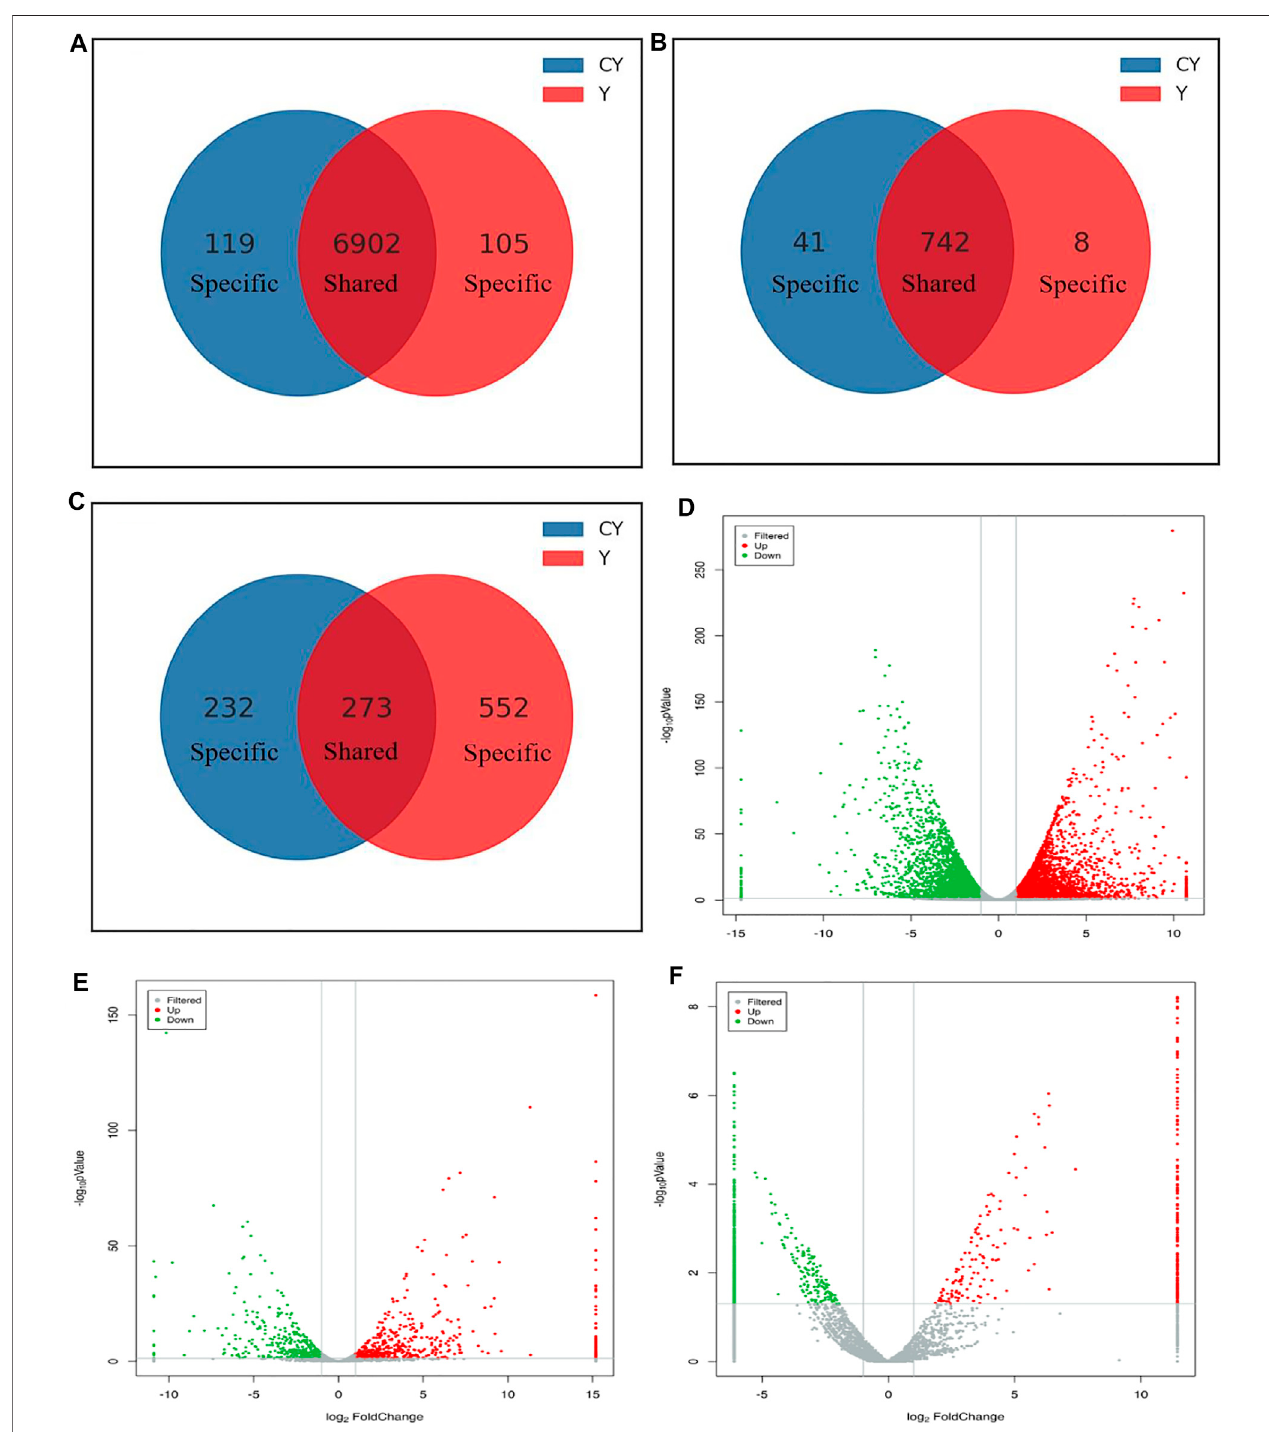
FIGURE2| ComparativeanalysisofthedifferentiallyexpressedmRNAsandncRNAsbetweencattle-yaksandyaks.Thespeci fi candsharedmRNAs (A) ,lncRNAs (B) , and circRNAs (C) between the two groups. The analysis of differentially expressed mRNAs (D) , lncRNAs (E) , and circRNAs (F) between two groups. Note: The red and green points represented upregulated and downregulated mRNAs, lncRNAs, and circRNAs, respectively. The gray points represented no signi fi cant differences. The gray vertical lines showed |log2FC| (cid:2) 1, and the gray horizontal lines showed p (cid:2) 0.05.